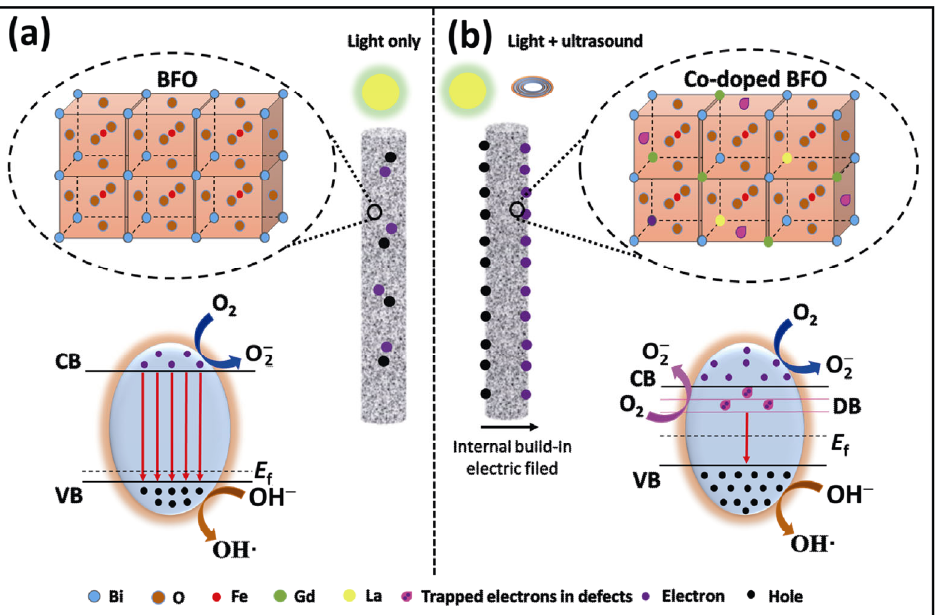
Fig. 4 Schematic illustration of the crystal structure and possible charge transfer mechanism: (a) BFO nanotubes under only light irradiation and (b) (Gd,La) co-doped BFO nanotubes under both light and ultrasound